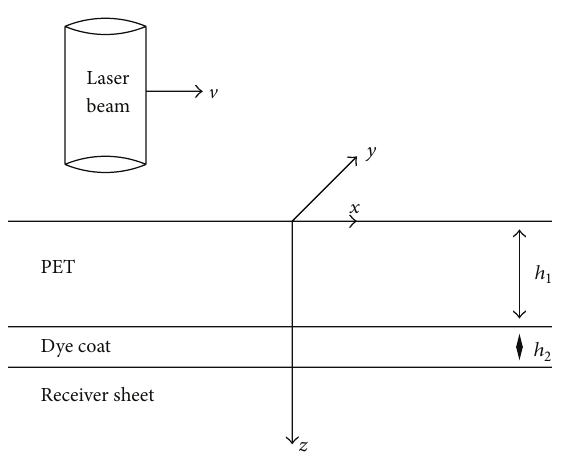
Figure 1: Illustration of the geometrical situation (not to